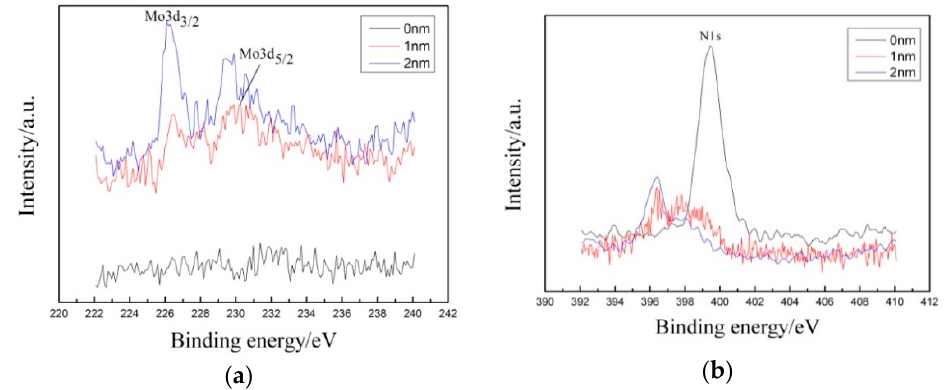
Figure 10. The high resolution XPS spectra of Mo3d 5/2 ( a ) and N1s ( b ) at different sputtering depths.